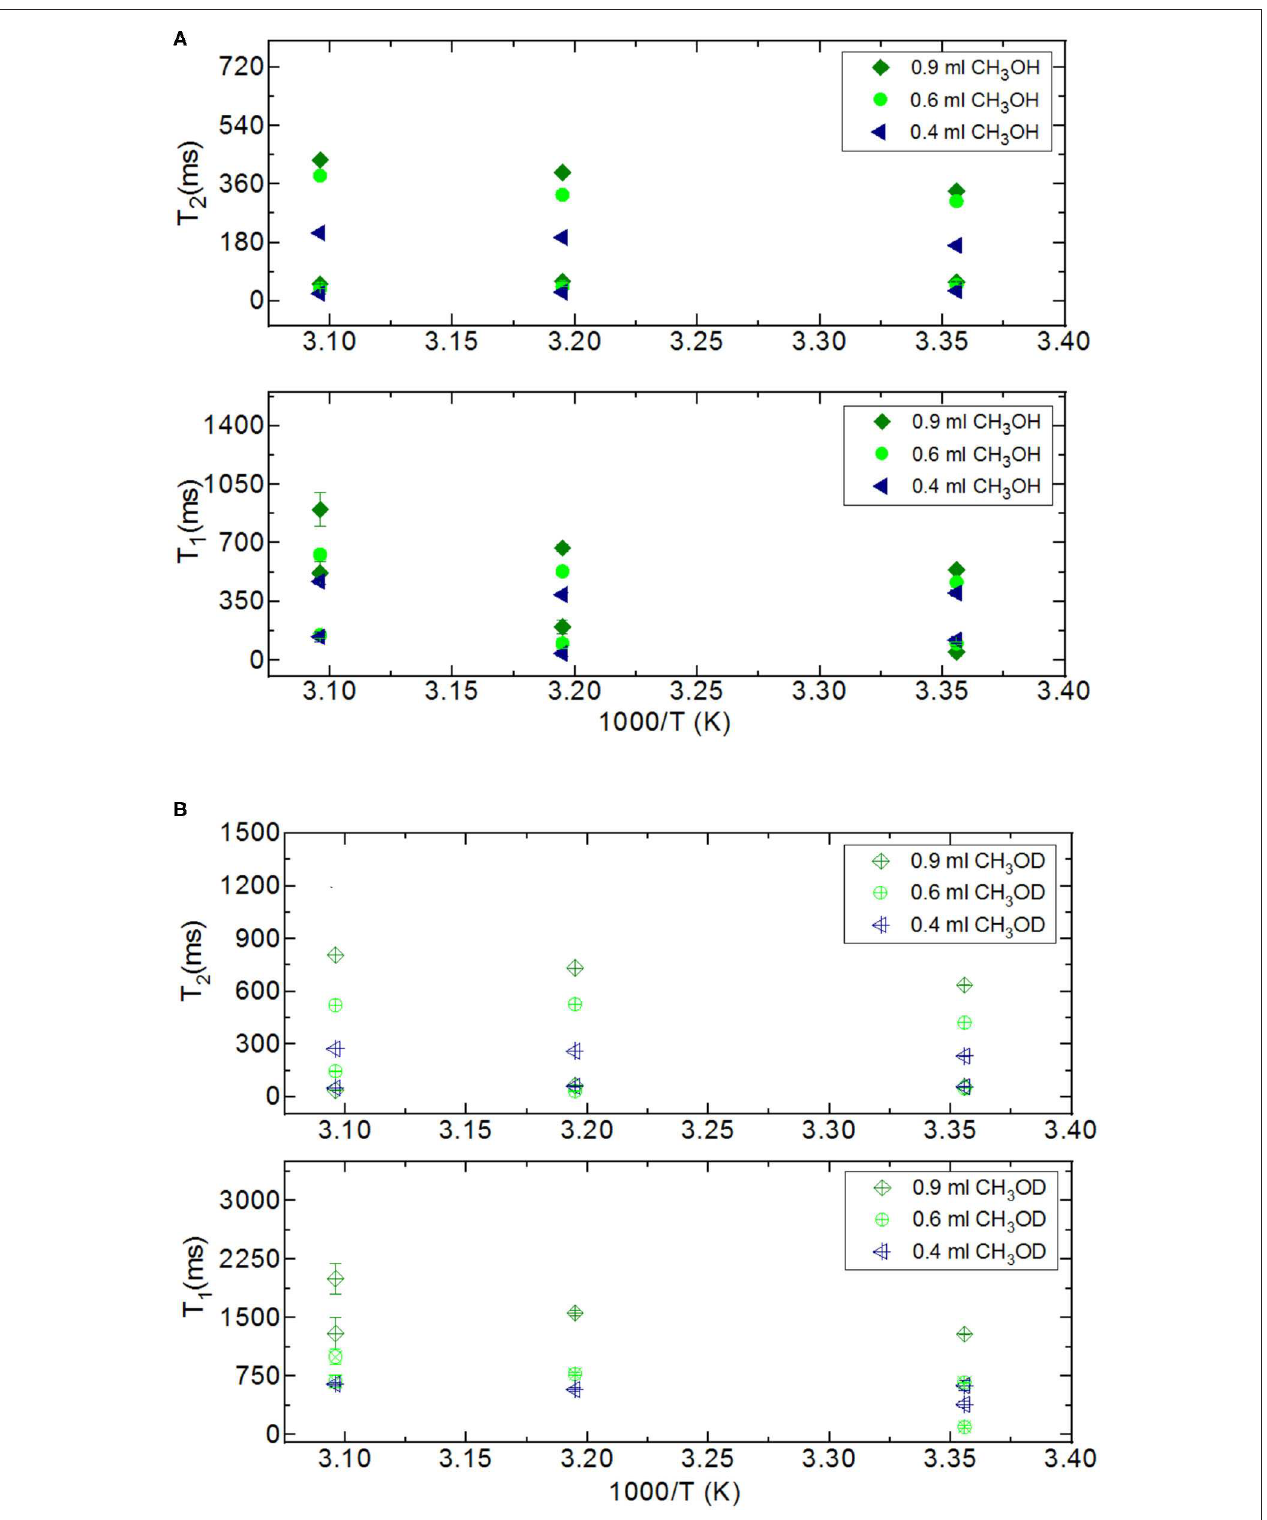
FIGURE 5 | Comparison of relaxation values of CH 3 OH and CH 3 OD confined into silica-4.0nm with the amount of 150mg and S/V = 574 where the variables are temperature values (298, 313, and 323K), and fluid-to-solid ratios (0.90 ml/150mg, 0.60 ml/150mg, 0.40 ml/150mg); CH 3 OH (A) , CH 3 OD (B) .